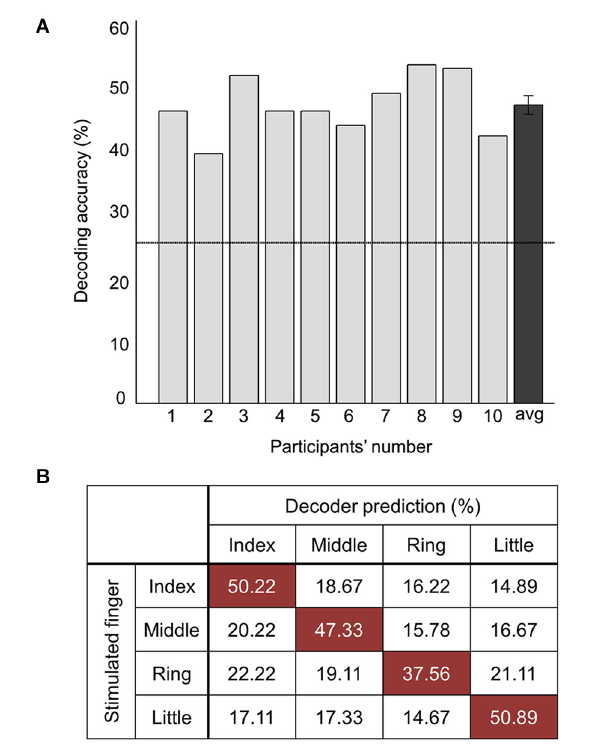
FIGURE 4 | Decoding performance combining all the voxels of significant clusters. (A) Average decoding accuracies of ten participants from searchlight MVPA. The rightmost value indicates the average accuracy across all the participants. Error bars indicate standard errors and a chance level is marked by the dashed line (25%). (B) Confusion matrix for the stimulated finger decoding analysis. The rows of the matrix indicate the locations of vibrotactile stimulus provided to the participants (i.e., true label) and the columns of the matrix indicate the predictions by the decoder (i.e., predicted label). Each cell shows the percentage of correct